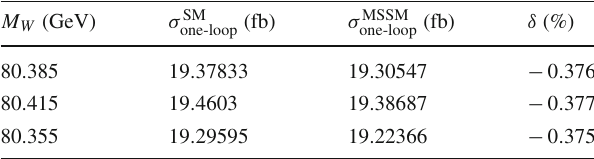
Table 1 The effect of currently measured W boson mass ( M W = 80 . 385 ± 0 . 015GeV) on the cross section of e + e − → W + W − in the higgsino world. The benchmark point is μ = 152 . 68GeV, tan β